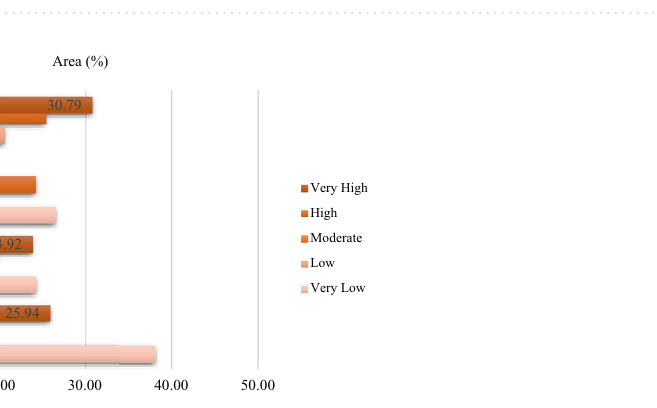
Figure 8. Frost-affected areas in the LUB form 2002 to 2021, generated in the ArcGIS 10.6 software (www. esri. com).